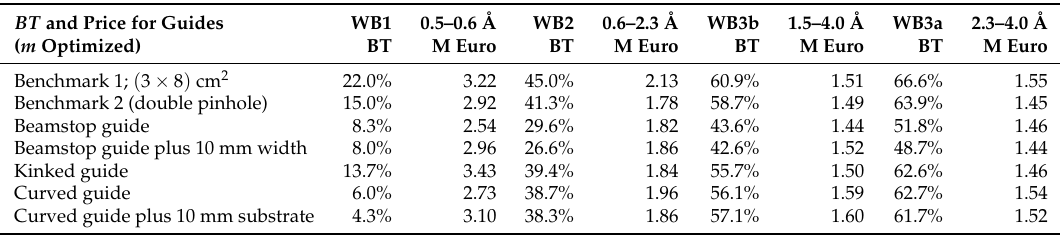
Table 2. The wavelength integrated BT ( λ ) for each of the m -and-shape-optimized guides tested in this report, shown for each of the four wavelength